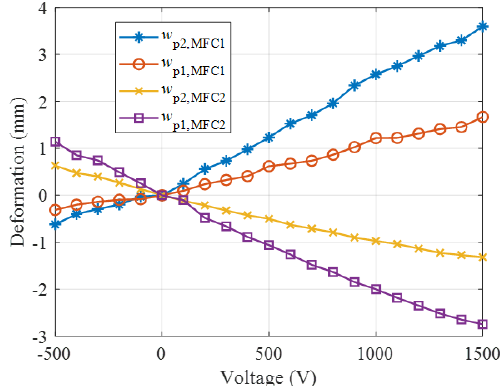
Figure 9. Deflection of the measurement points using a single MFC actuator.